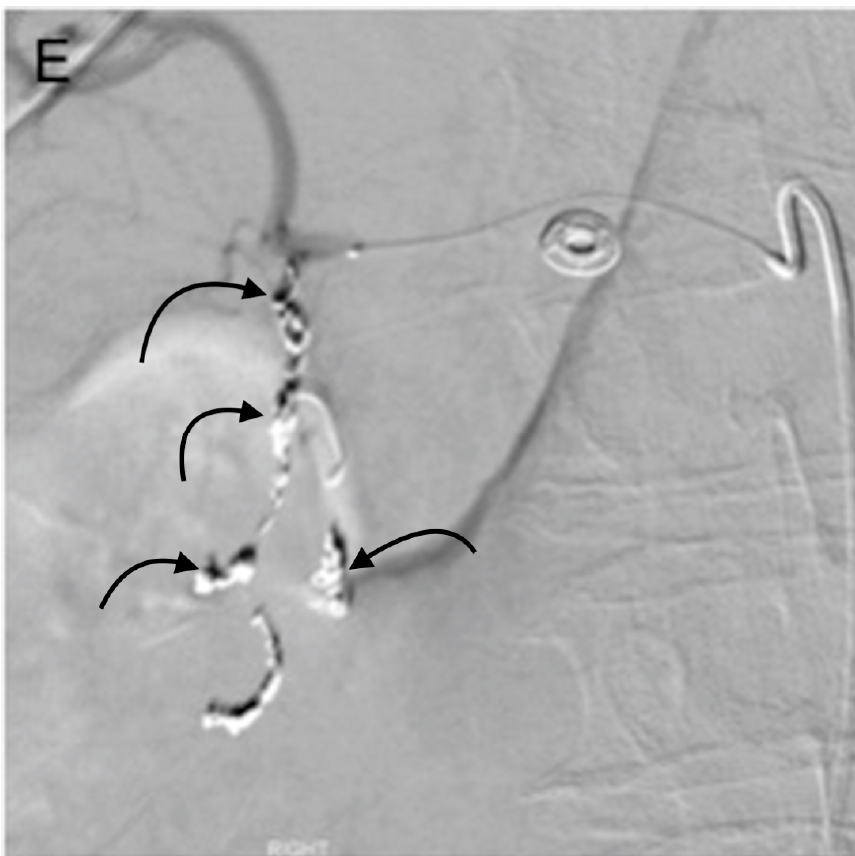
Figure 3. This 77 year old woman had a known history of multiple gastric and duodenal ulcers, and presented with massive upper gastrointestinal (GI) bleeding. A ( A ) celiac angiogram showed severely clamped down vessels that were consistent with hypotensive state and vasopressor use. The ( B ) native and ( C ) subtracted images show multiple sites of extravasation (black arrows). The coils embolization (black curved arrow) was done distal to the extravasation (black straight arrow) ( D ) and back to the origin of the GDA as it arose from the common hepatic artery ( E ). The bleeding was successful stopped.